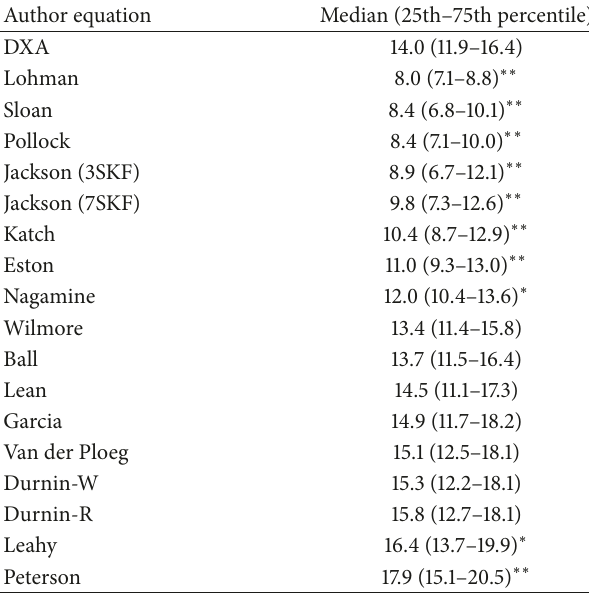
Table 6: Body fat percentage measured with DXA and estimated with anthropometric equations developed in nonathletic popula- tions.